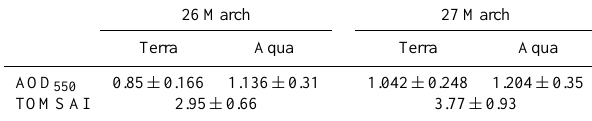
depicts clearly the intensity of the dust storm that engulfed Table 2. MODIS Deep Blue AOD 550 obtained over the Kuwait